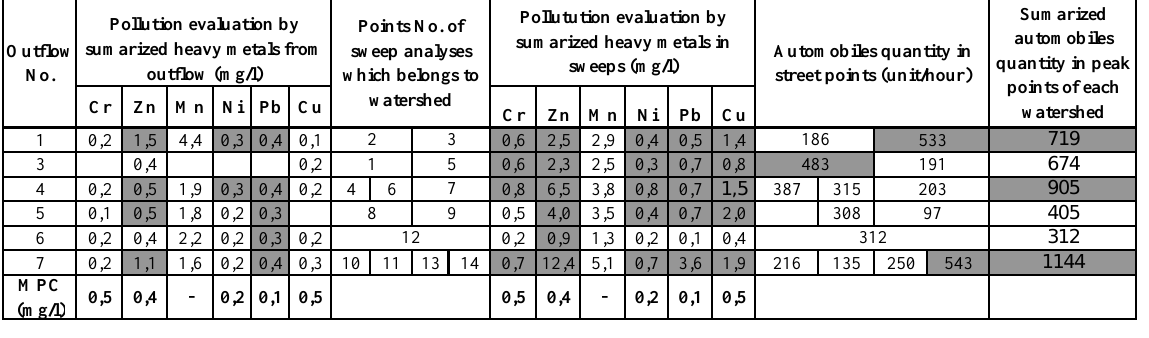
Cells in grey exceed MPC and have maximum values of transport Empty cells - results are above confidence interval